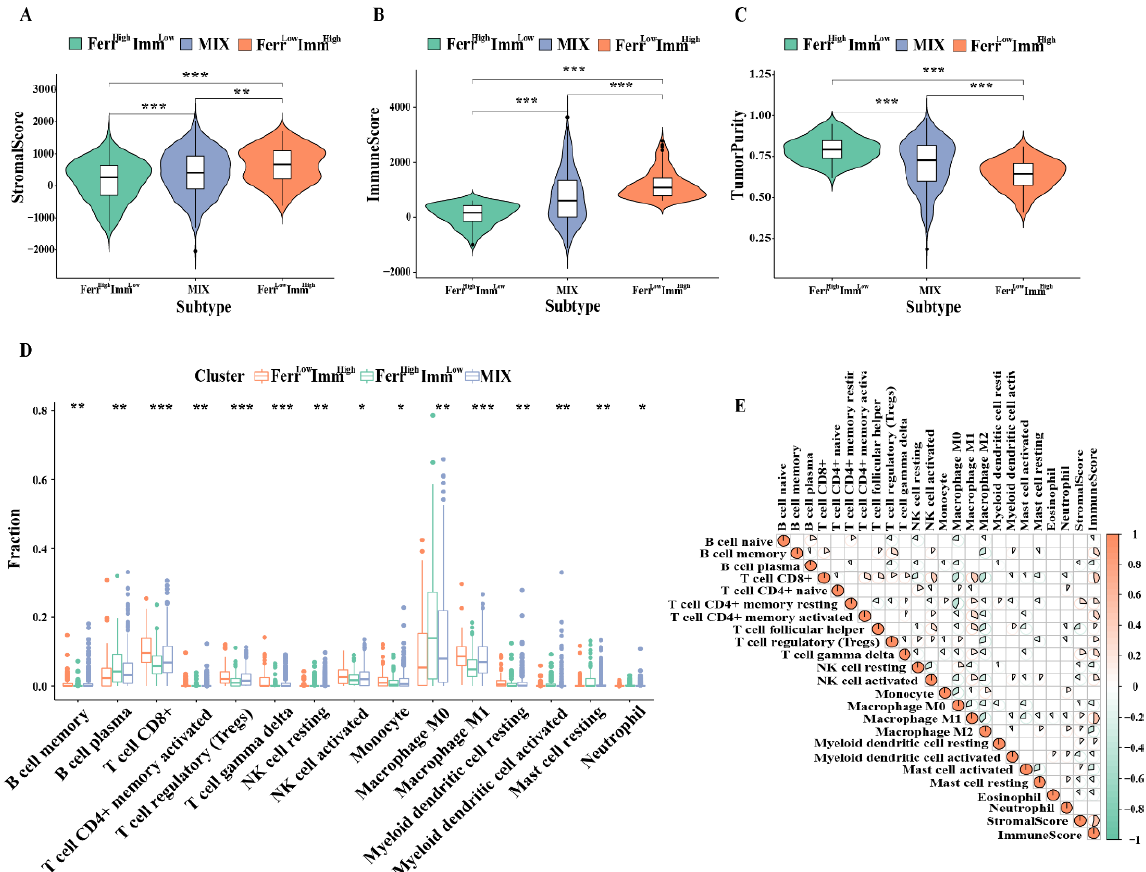
Figure 4. Distribution of immune microenvironment in subtypes: ( A – C ) Comparison of tumor microenvironment score (stromalscore, immunescore, and tumorscore) between three groups. ( D ) Comparison of infiltrating immune cells (CIBERSORT) between three groups. ( E ) Spearman correlation analysis was conducted to determine the correlation of immune cells and microenvironment.